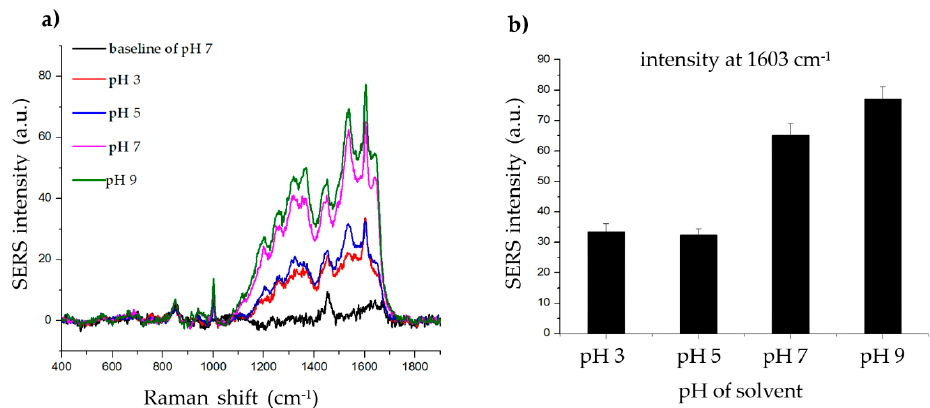
Figure 4. Effect of solvent pH on histamine detection. ( a ) Raman signal of histamine incubated with SiO 2 @Au@Ag nanoparticles (NPs) after 2 h in solvents (phosphate-buffered saline-Tween 20 (PBS-T)) with di ff erent pH values (3, 5, 7, and 9). ( b ) The Raman intensity of histamine in solvents (PBS-T) with di ff erent pH values (3, 5, 7, and 9) (at 1603 cm − 1 ).